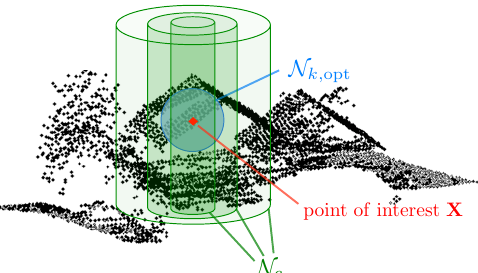
Figure 1. Concept sketch of neighbourhood definitions used in this work as basis for extracting features for a considered 3D point X : cylindrical neighbourhood definitions N c and the spher- ical neighbourhood N k, opt formed by an optimal number k opt of nearest